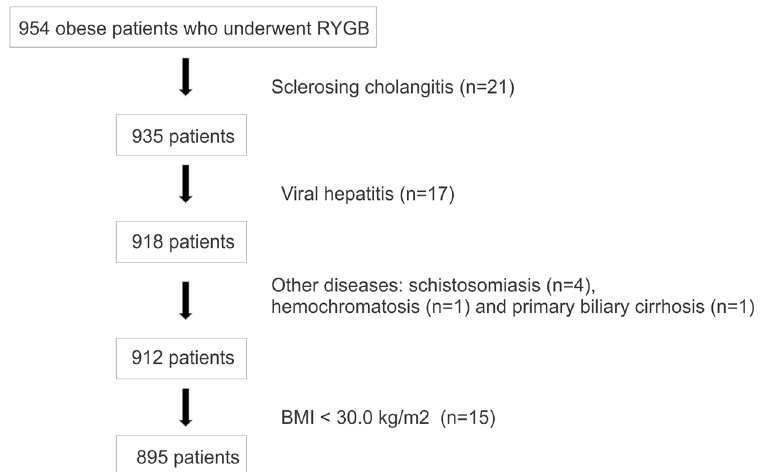
Figure 1. Patients enrolled in the observational study. Flowchart showing the patients who were excluded from the study. Obese patients operated by the Department of Surgery of the University of Campinas from 2008 to 2019. The exclusion criteria were based in age ( < 18 e > 80 years-old), BMI less than 30 kg/m 2 at the time of surgery, lack of information in medical records and pre-existing liver diseases. RYGB: Roux-en-Y Gastric Bypass. BMI: body mass